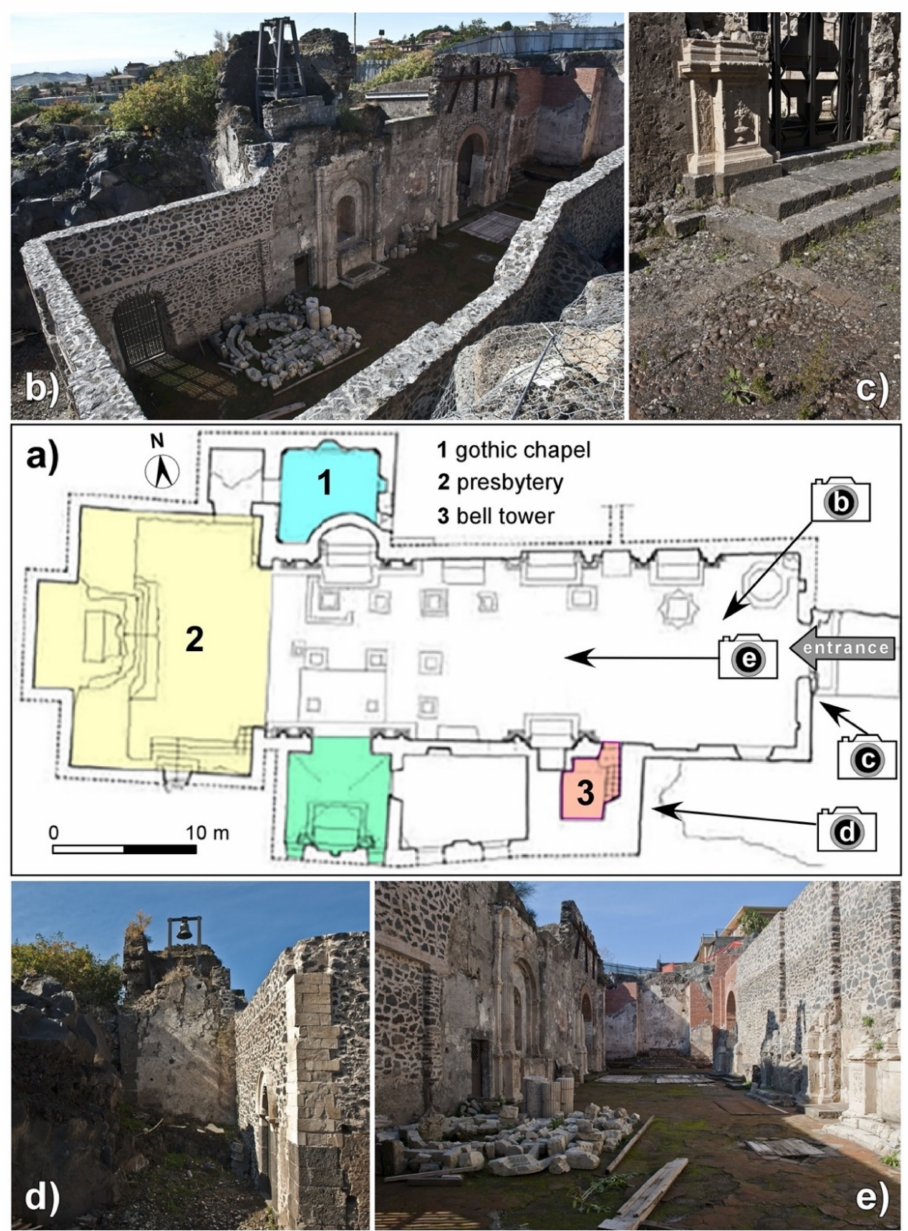
Figure 4. ( a ) Plan of the Mother Church [11]; ( b ) panoramic view of the church after the first restoration works (the wood roof shown in Figure 4b was added with the second tranche of works), taken from the level of the basaltic embankment; ( c ) detail of the entrance portal; ( d ) lateral entrance door and base of the bell tower; ( e ) view of the nave with ornaments and decorations; note that a large part of the right wall and the corner of the left wall were reconstructed after the restoration interventions (photos taken in 2012 by R.